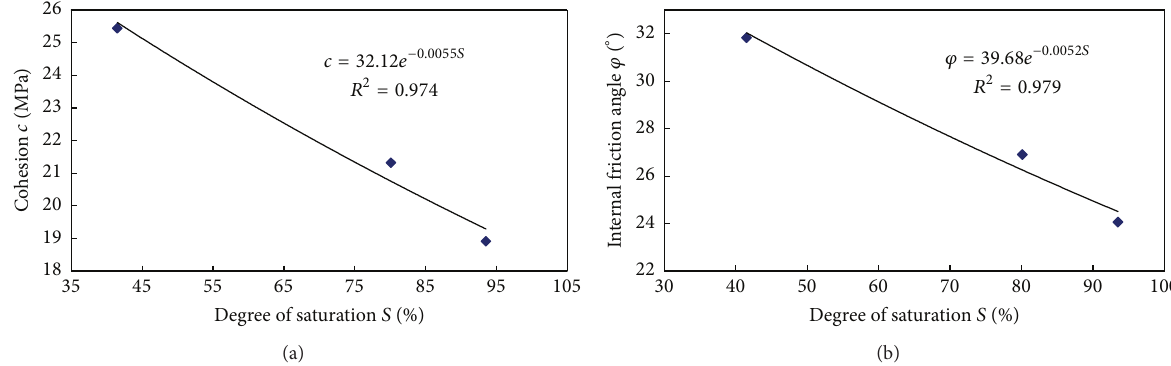
Figure 4: Relationships between the peak strength parameters and saturation degree of specimens: (a) 𝑐 - 𝑆 ; (b) 𝜑 - 𝑆 .